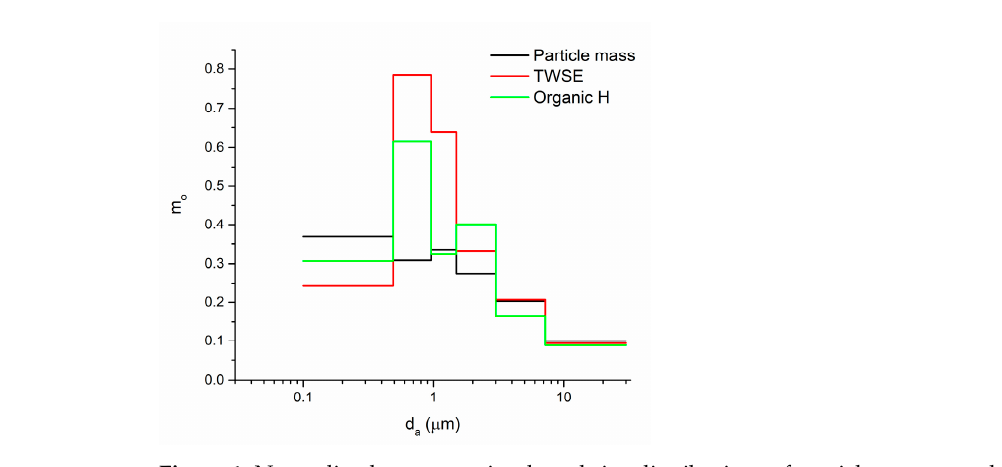
Figure 1. Normalized concentration-based size distributions of particles mass, total water-soluble extract (TWSE), and total non-exchangeable organic hydrogen concentrations (Organic [H]).